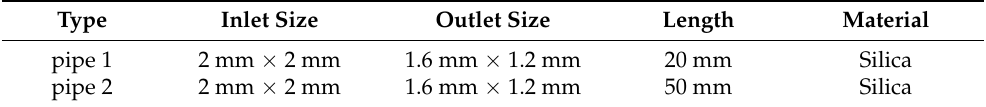
Table 1. Parameters of the two homogenizing pipes.